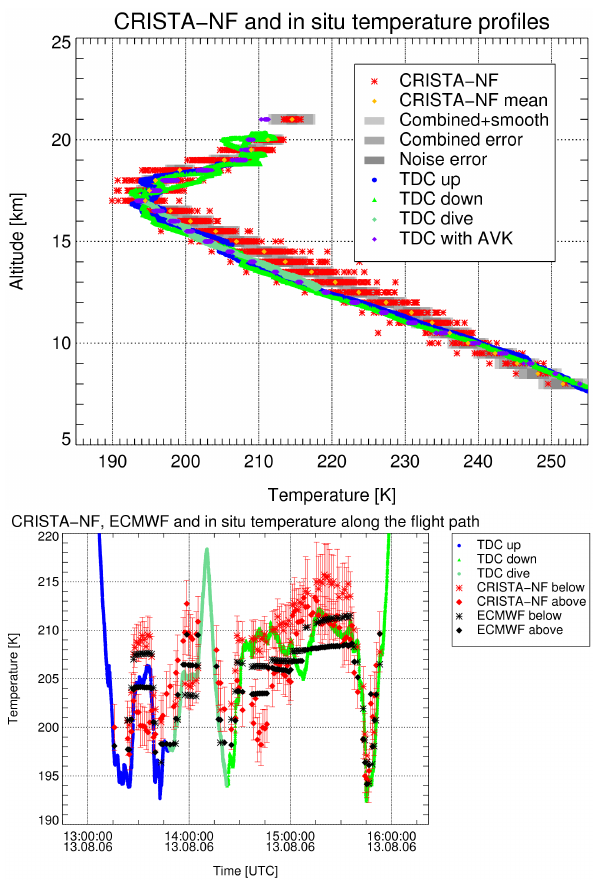
Fig. 8. CRISTA-NF and TDC temperatures during flight L5 shown as profiles (a) and along the flight path (b) . Along the flight the CRISTA-NF temperature from the retrieval grid point below and above the flight path are shown. Error bars on CRISTA-NF data indicate combined plus smoothing